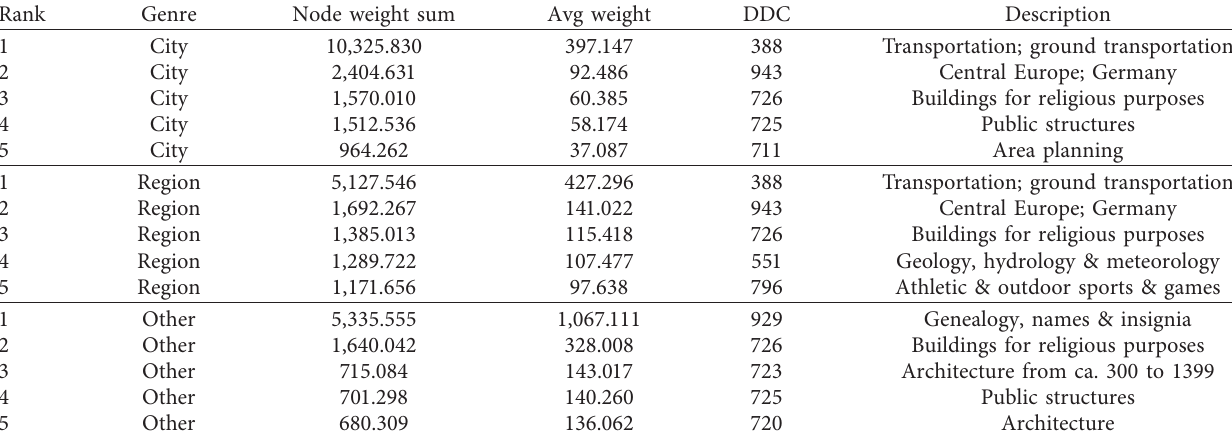
ITIES , R EGIONS , and O THERS .